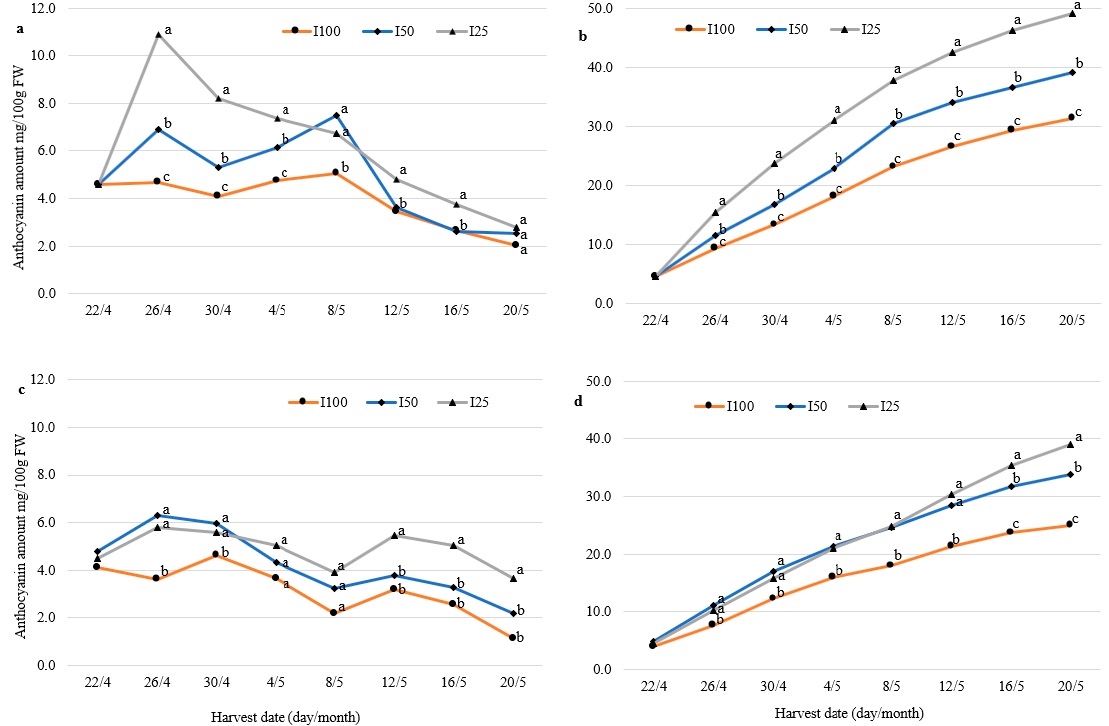
Figure 2. Dynamics of total anthocyanin content (mg/100g fresh weight) in the berries of wild strawberry “Rojan” ( a ) and No. 17 ( c ) and cumulative anthocyanin content ( b ) and ( d ), respectively. Plants were fully irrigated (I100) and irrigated with half (I50) and a quarter (I25) of full irrigation. Data followed by the same letter are not significantly different according to the LSD test at p ≤ 0.05.